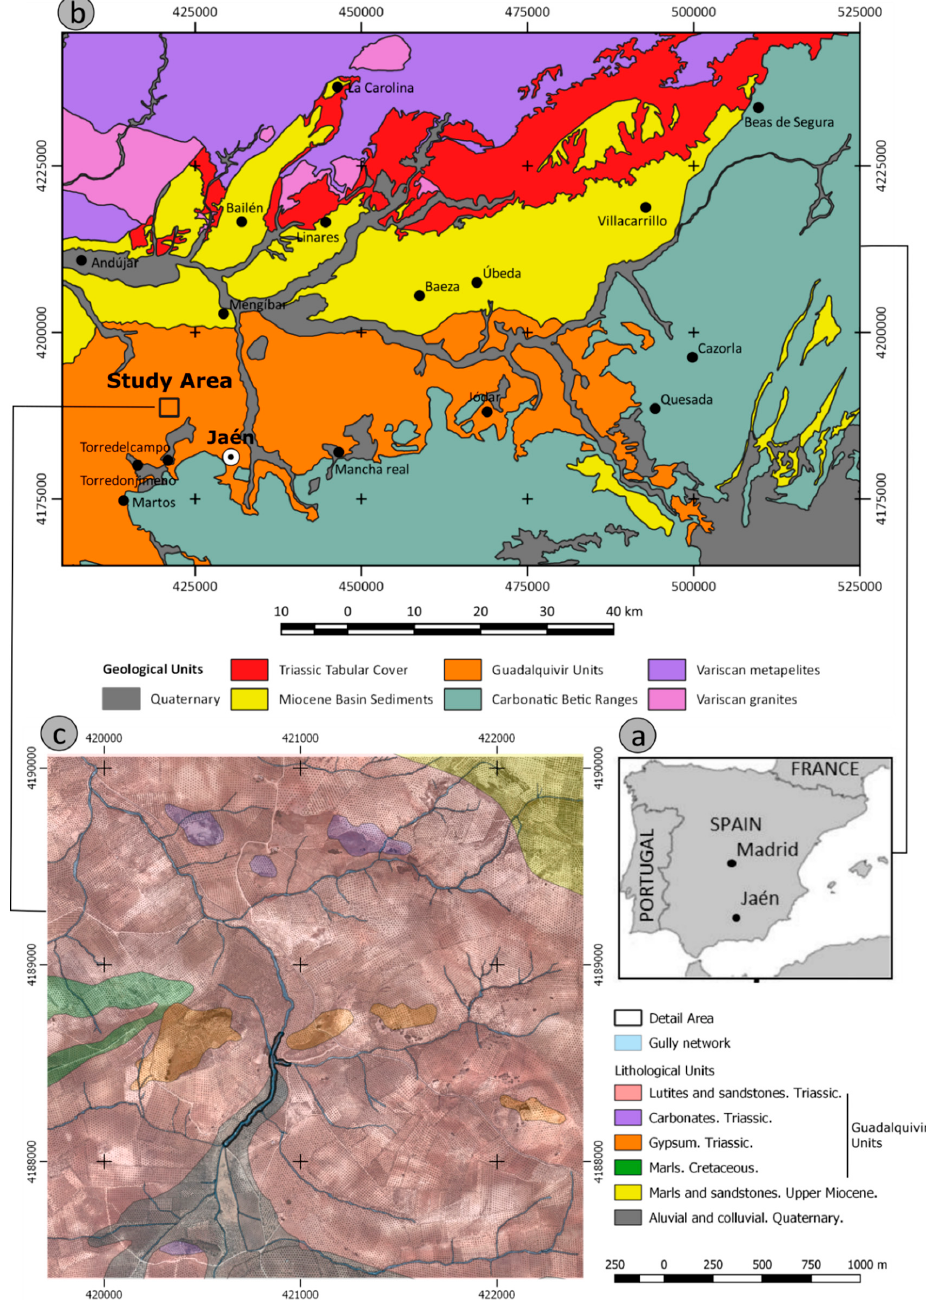
Figure 1. Geographical and geological location: ( a ) geographical location; ( b ) geological setting; ( c ) study area: lithological units and gully network delimited from the analysis made in this study (DoD of the complete period) and photointerpretation. Coordinates are in ETRS89-UTM30. The province of Jaén is the area with the largest extension of olive groves in the world. It occupies 48% of the arable area of the province [62] and represents 59% of the surface of this crop in Spain, 30% in Europe and 19% in the world [63]. The olive grove connects the economic, cultural and social life of the province, being also its most emblematic landscape. However, its sustainability is exposed to several threats, mainly due to the intensification of the crop, which has reduced the quality of the